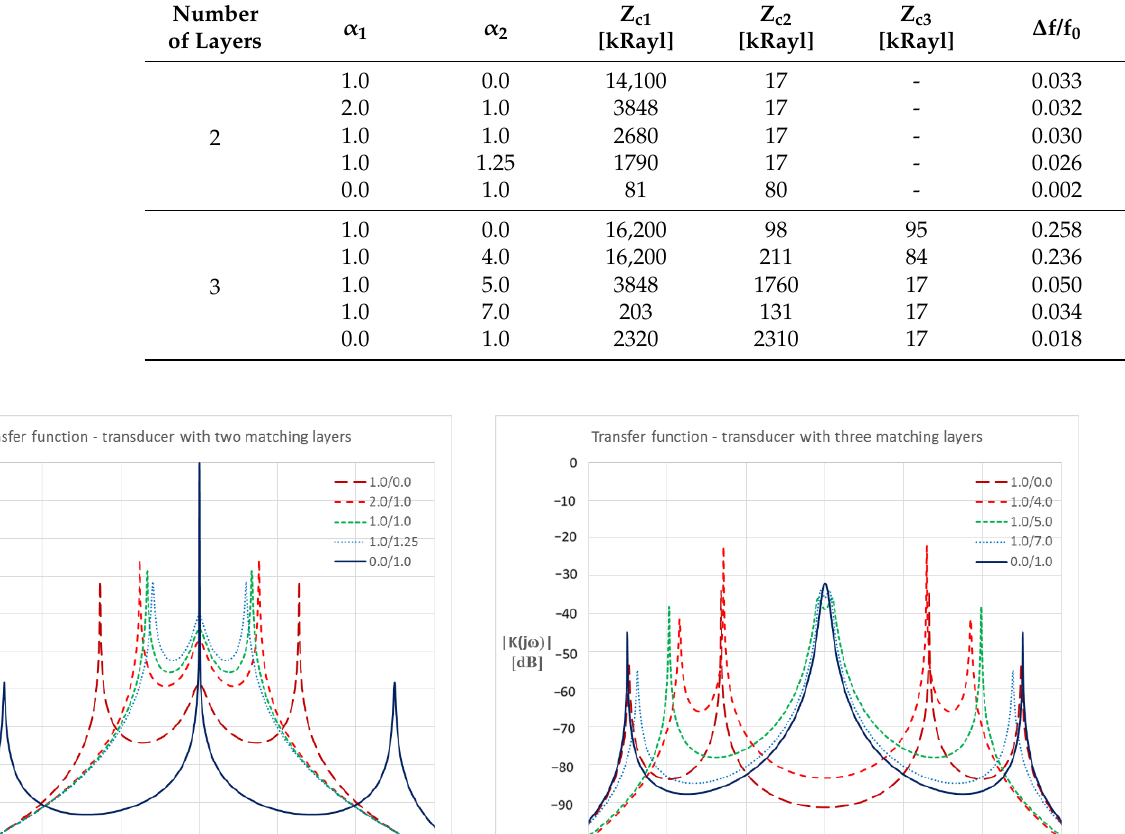
Table 2. Acoustic impedances of the matching layers obtained with the genetic algorithm (water, Z T = 1500 kRayl, the impact of α 1 and α 2 coefficients).